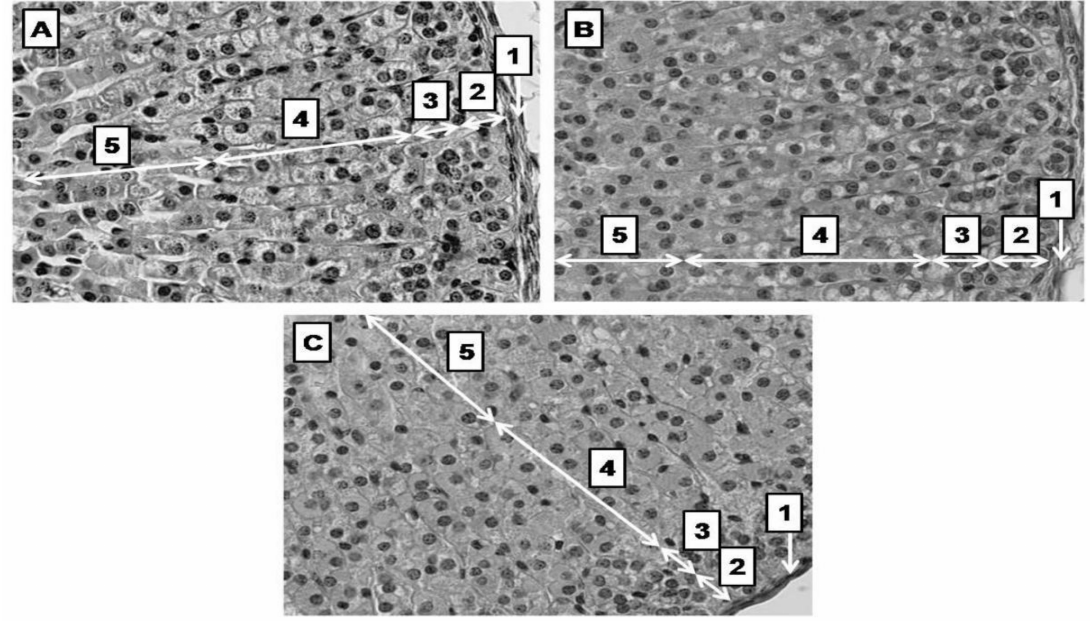
Figure 3. Adrenal morphology is changed after PSS . Adrenal cortex of high-anxiety ( A ), low-anxiety ( B ), and control ( C ) rats. 1, capsule; 2, zona glomerulosa ; 3, zona intermedia ; 4, zona fasciculata ; 5, zona reticularis